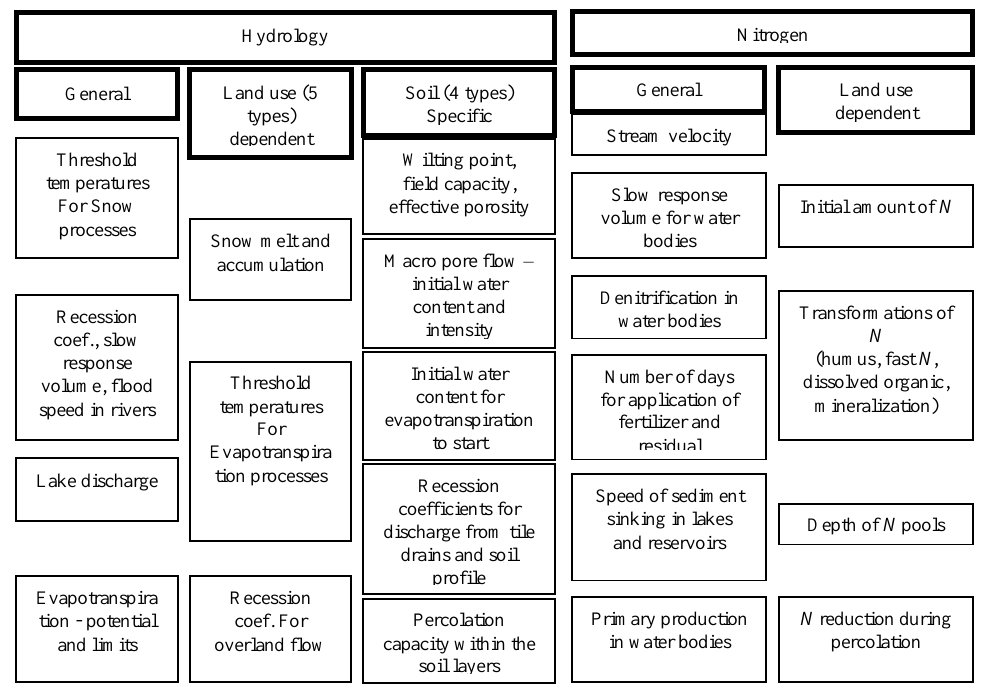
Fig. 3. Calibrated parameters selected for discharge and nitrogen simulation for the Berze